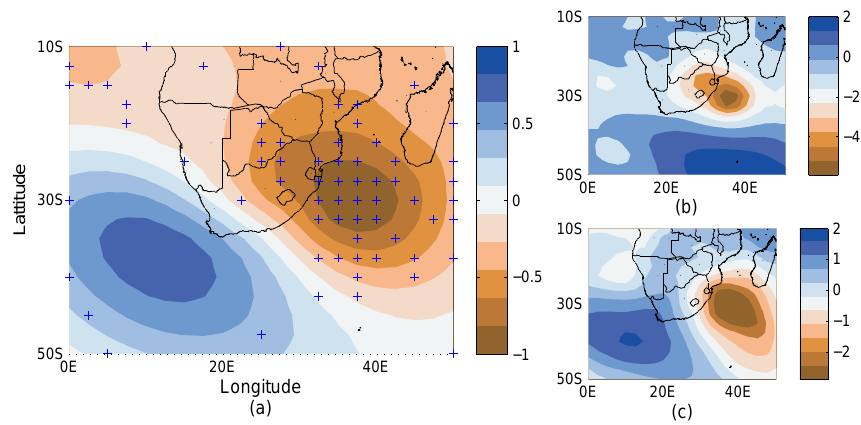
Fig. 3. (a) Average CP03 with ( + ) symbols indicating the centers of all negative anomalies (low pressures) contributing to the class. (b) & (c) show actual CP’s for the dates 19/03/2007 and 30/08/2006 respectively, both of which were classified as members of the CP03 class.